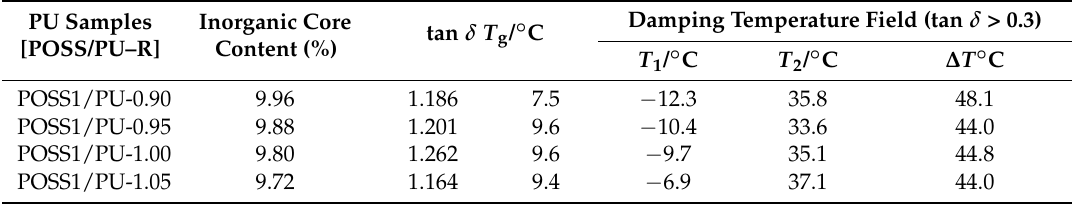
Table 7. Summary of DMA data of PUs with different molecular weights of